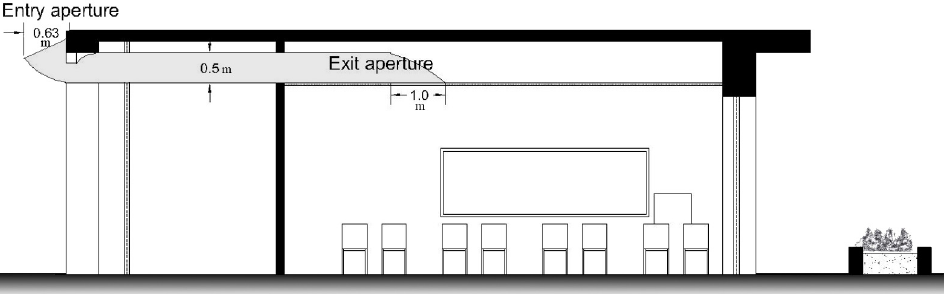
Figure 12. Section in a typical classroom showing the suggested southern anidolic duct.